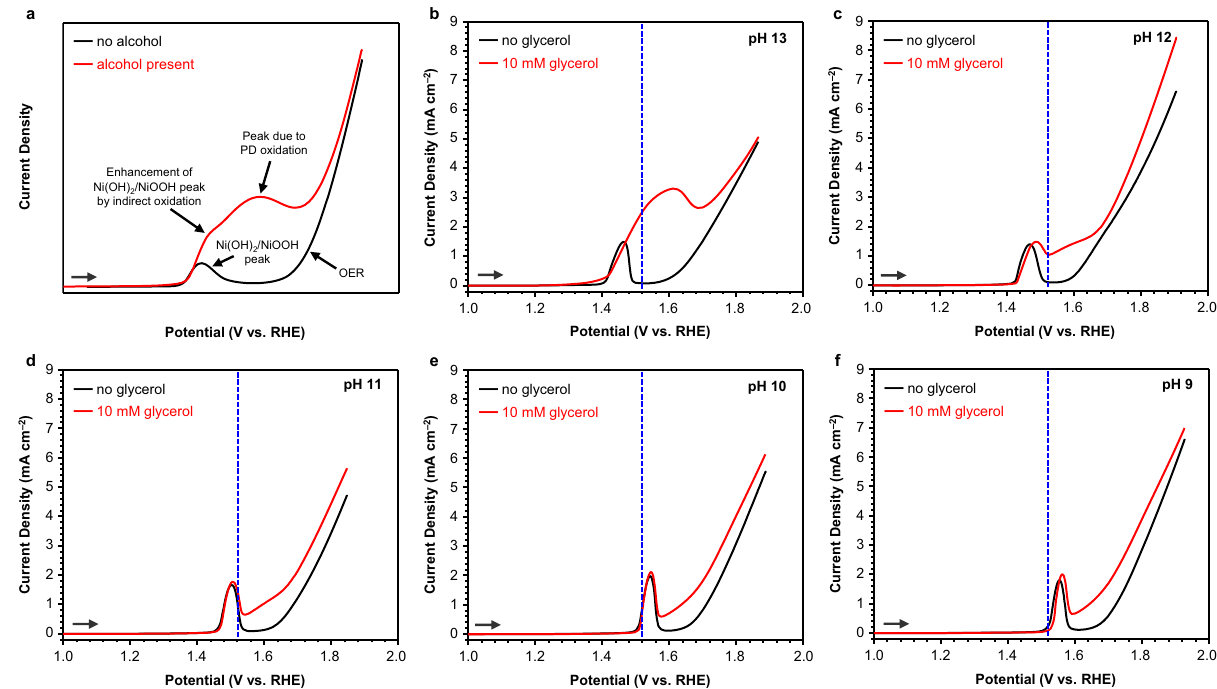
Fig. 3 | Linear sweep voltammograms (LSVs) of α -Ni(OH) 2 fi lms. a Schematic LSVs with (red) or without (black) an alcohol demonstrating expected anodic fea- tures. b – f LSVs obtained with (red) or without (black) 10mM glycerol at pH 9-13